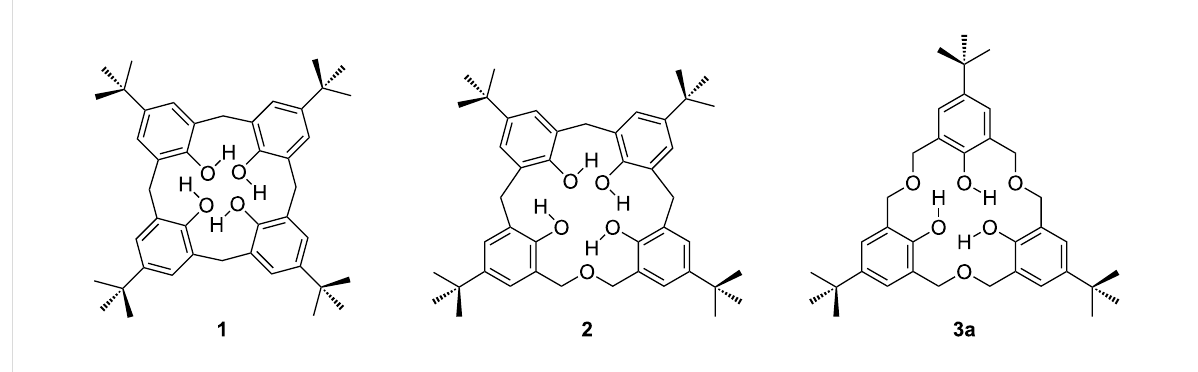
Figure 1: Calixarenes and expanded calixarenes: p - tert -Butylcalix[4]arene ( 1 ), p - tert -butyldihomooxacalix[4]arene ( 2 ), p - tert -butylhexahomotrioxa- calix[3]arene ( 3a ).